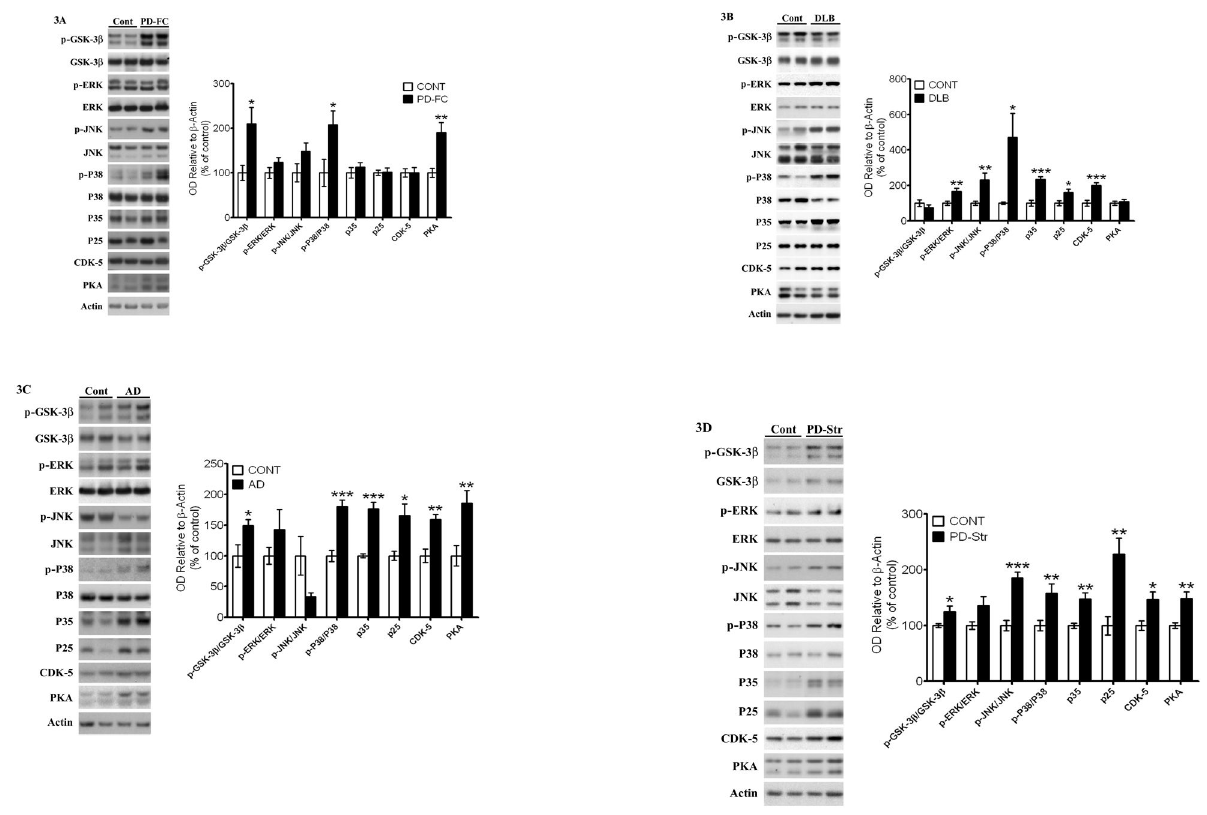
Figure 3. Identification of Tau kinases activated in FC of PD, DLB, AD and PD striata. [A] . FC from PD and non-diseased controls, [B] FC from DLB cases and non-diseased controls, [C] FC from AD cases and non-diseased controls, and [D] Postmortem striata from PD cases and non-diseased controls, were probed using immunoblots for expression of the various Tau kinases, using antibodies listed in Table S1 in File S1. N values for all samples were as listed in legend to Figure 1. Activating phosphorylations of p-GSK-3β, p-ERK, p-JNK, and p-p38 were probed in parallel with phospho-specific antibodies [see Table S1 in File S1]. OD was analyzed as total kinase relative to GAPDH [p35, p25, cdk5, and PKA] or as phosphorylated kinase relative to total kinase [GSK-3β. JNK, p39MAPK and ERK] and are presented as percent of corresponding control cases [mean ± SEM]. Data for each kinase were analyzed by t-test for difference from corresponding control group [*p<0.05; **p<0.01]. doi: